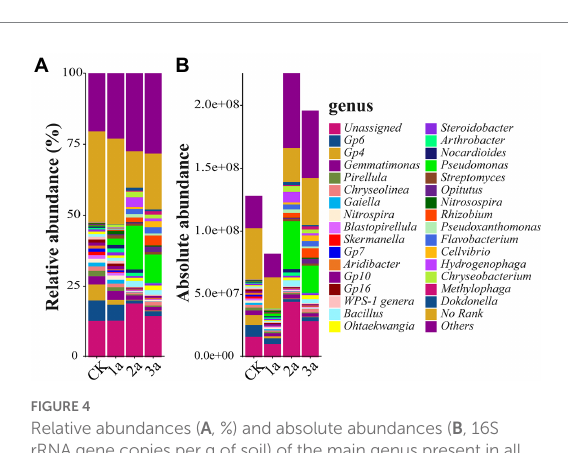
FIGURE 3 Relative abundances ( A , %) and absolute abundances ( B , 16S rRNA gene copies per g of soil) of the main phyla present in all samples. Different bar charts represent different soil samples, and the ordinate is the abundance value. CK, 1a, 2a, and 3a represent greenhouses consecutively planted for 0, 1, 2, and 3 years, respectively.